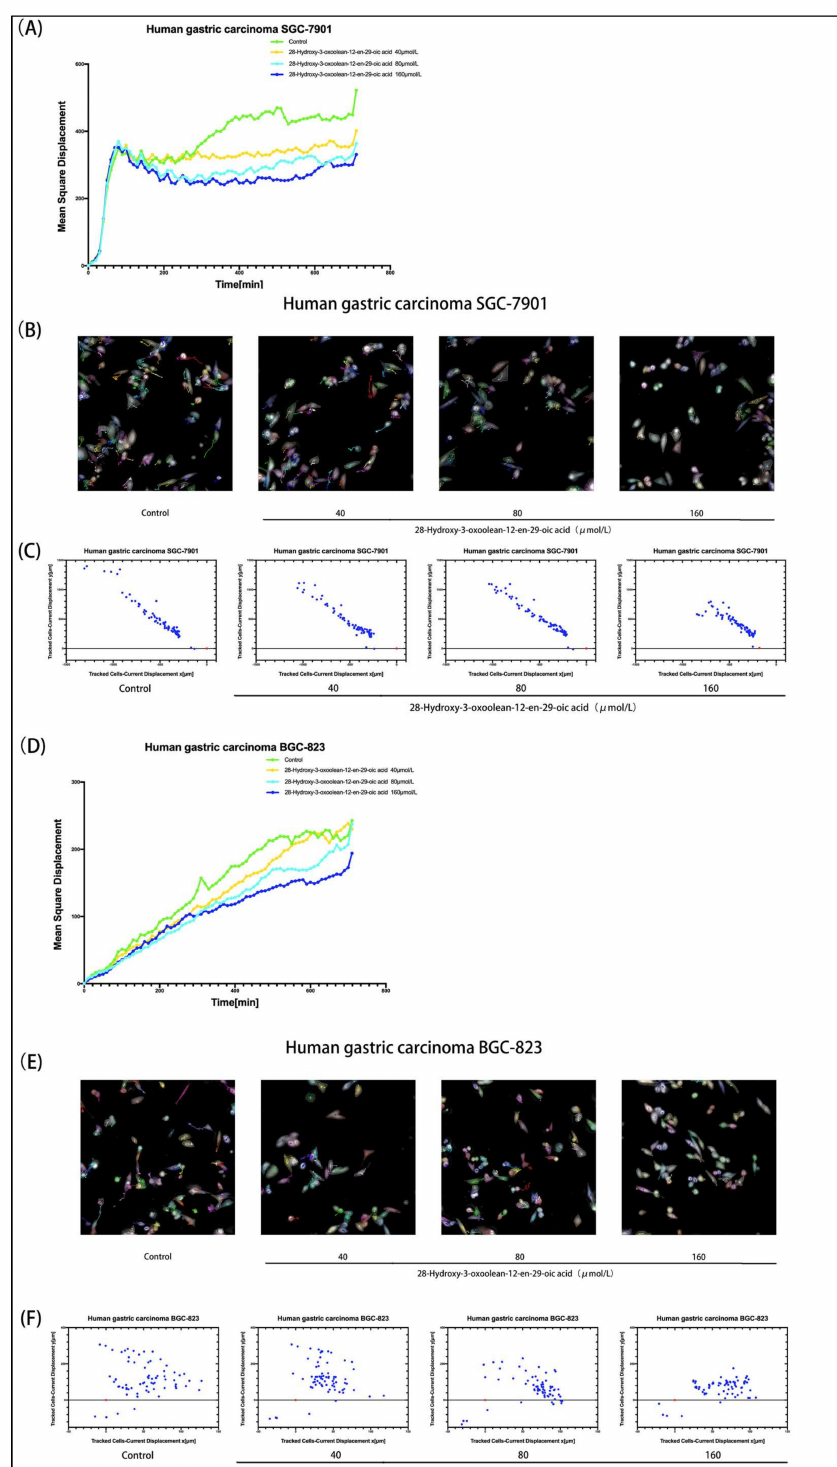
Figure 4. ( A , D ) After treatment with various concentrations of 28-hydroxy-3-oxoolean-12-en-29-oic acid (40, 80 and 160 µ mol / L) for 24 h, the mean square displacement was plotted vs. the observation time from well-level data. A chemokinesis assay was performed with digital phase contrast